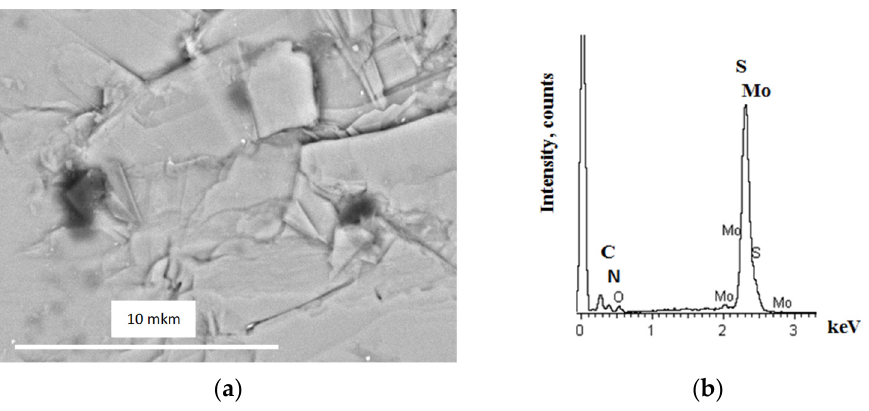
Figure 6. SEM image of molybdenite surface after its contact with a 0.1% DTM solution—( a ); and energy-dispersive spectrum of dark spots/areas with adsorbed reagent—( b